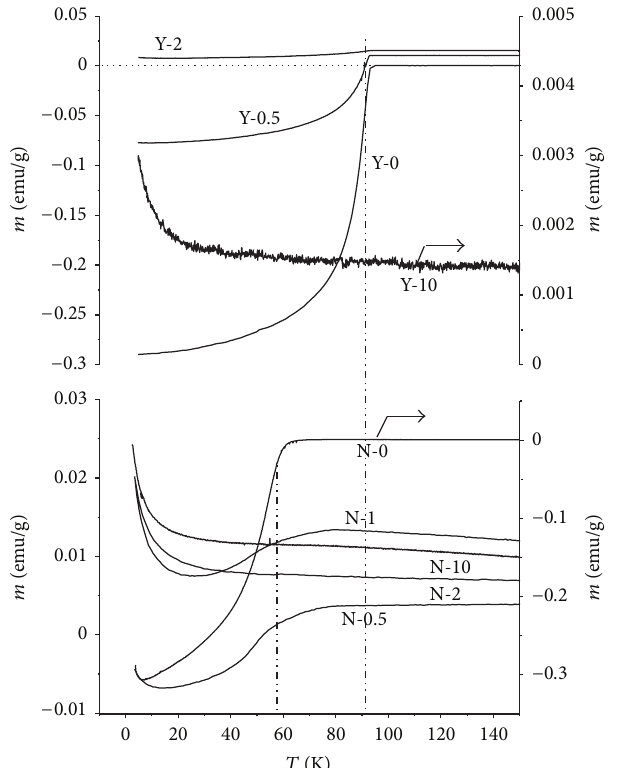
Figure 8: ZFC magnetizations as a function of temperature at 𝐻 = 50 Oe for the initial and mechanically activated samples: YBa 2 Cu 3 O 6+𝛿 (top); NdBa 2 Cu 3 O 6+𝛿 (bottom).